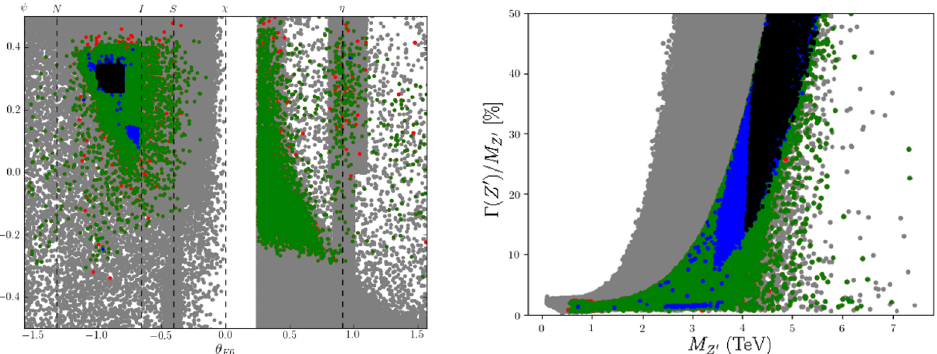
Figure 2 . The gauge kinetic mixing parameter (cid:20) versus U(1) 0 charge mixing angle (cid:18) E (left panel) 6 and the Z 0 width-to-mass ratio (cid:0)( Z 0 ) =M Z 0 vs the Z 0 mass M Z 0 (right panel). Our colour convention is as listed at the end of section 3. The vertical dashed lines in the left panel corresponds to well- known E 6 realisation with de(cid:12)ned (cid:18) E 6